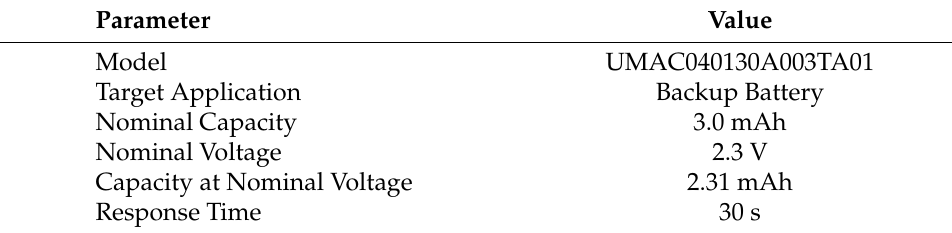
Table 1. Simulation parameters for the underwater sensor node